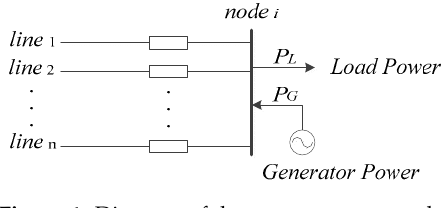
Figure 1. Diagram of the power system node.